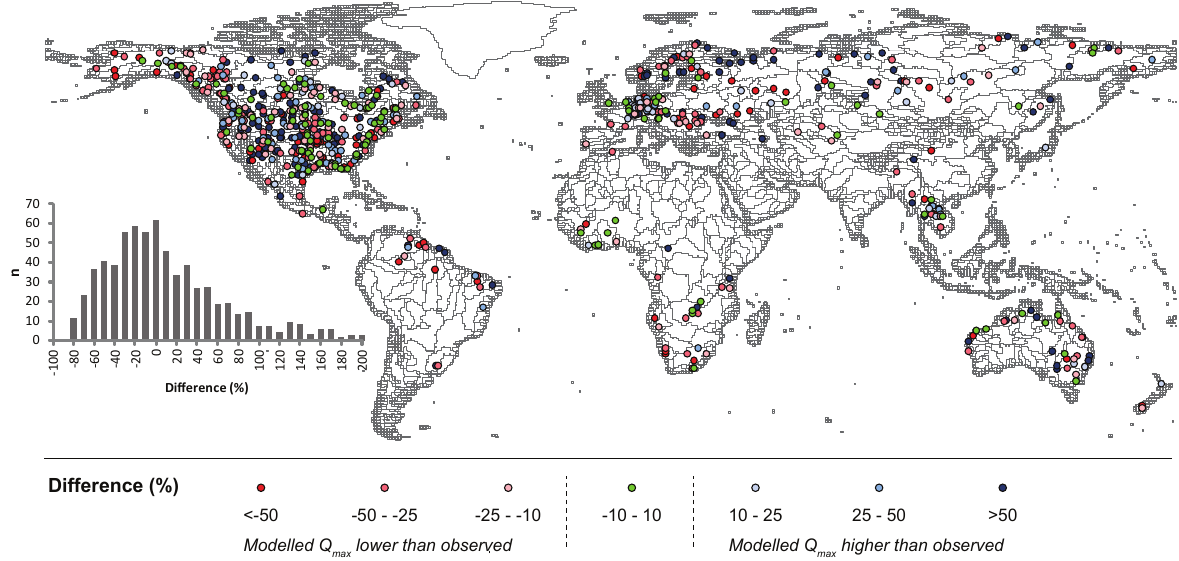
Fig. 1. Percentage difference between modelled and observed median Q max over the period 1959–2000. Inset shows histogram of values for individual locations (difference > 200% for 58 locations).